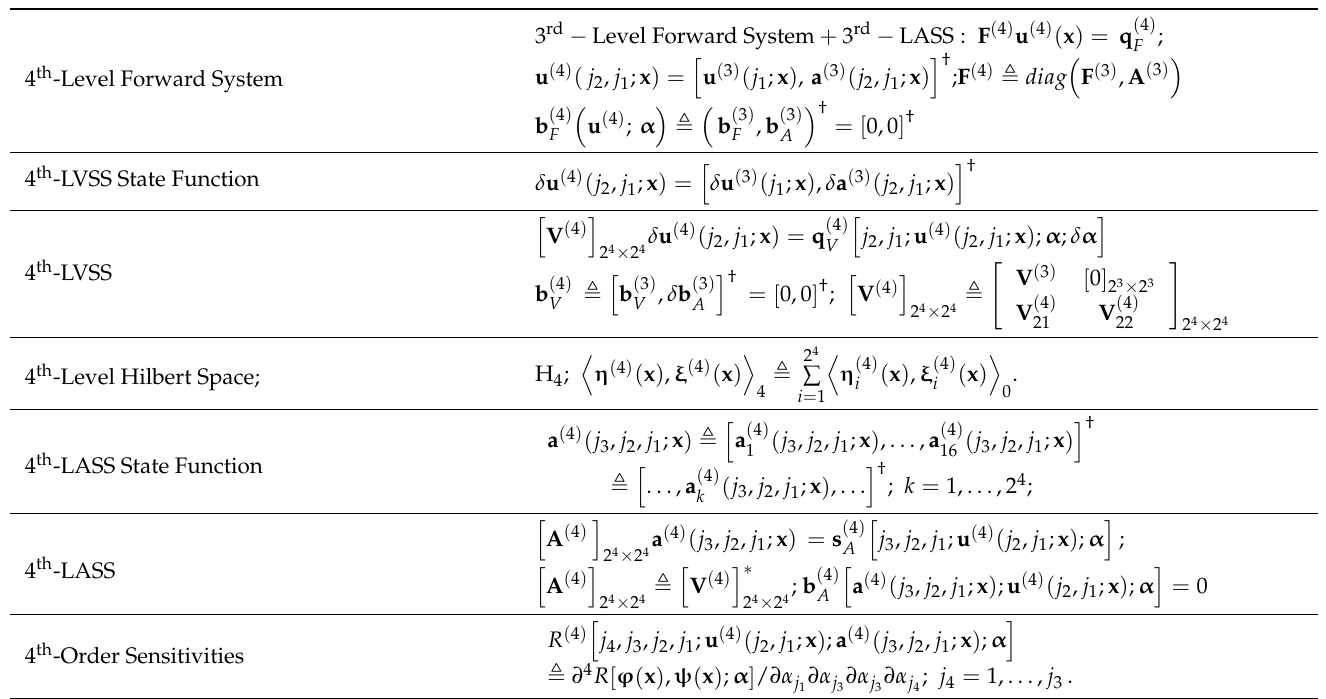
Table 4. Fourth-Order Sensitivities ( n =